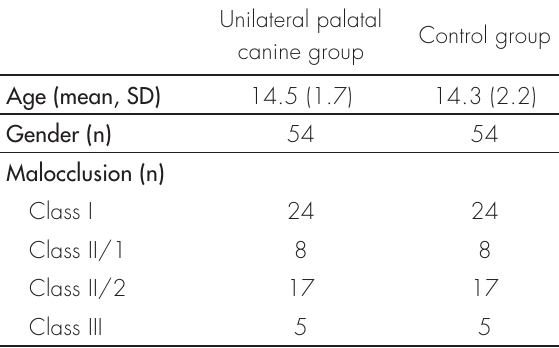
Table IV. Sample